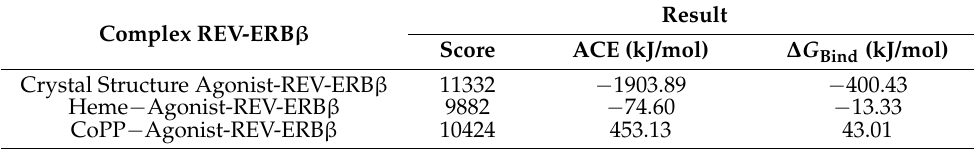
Table 4. Results of protein-peptide docking against nuclear receptor corepressor (NCoR).